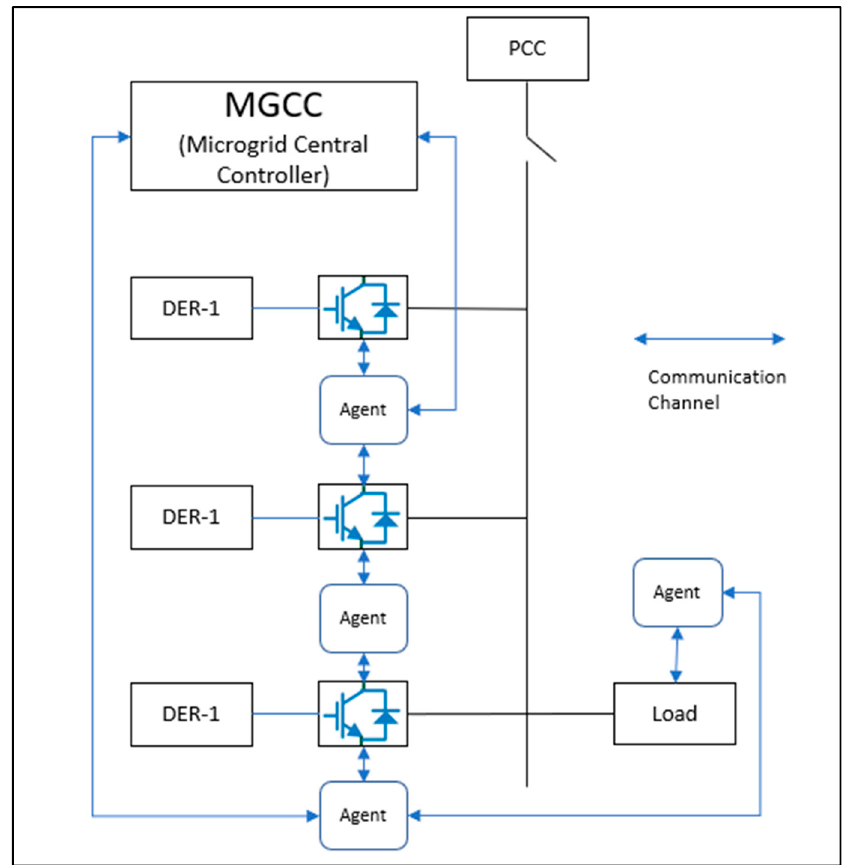
Figure 12. Sample architecture of multiagent control in a microgrid.